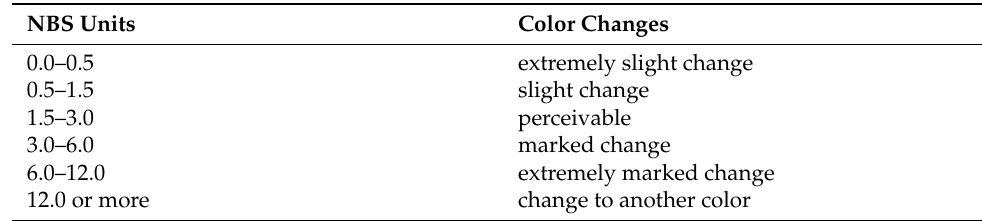
Table 2. Levels of color change, according to NBS.